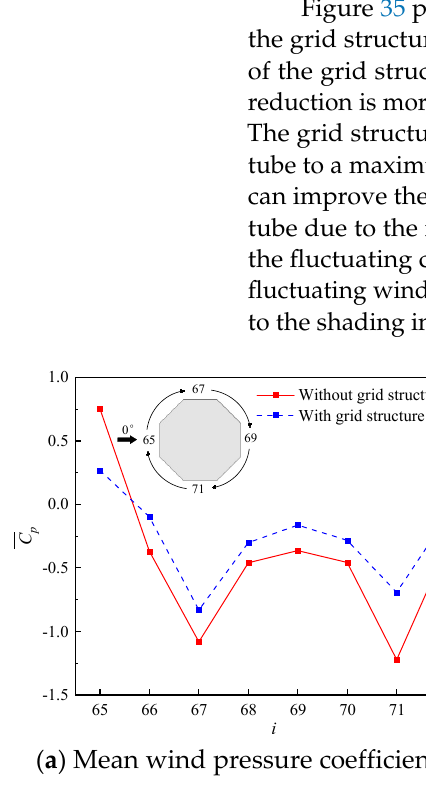
Figure 35. Wind pressure coefficients of the core tube with and without the grid structure on the 75 m layer at a 0° wind direction angle.